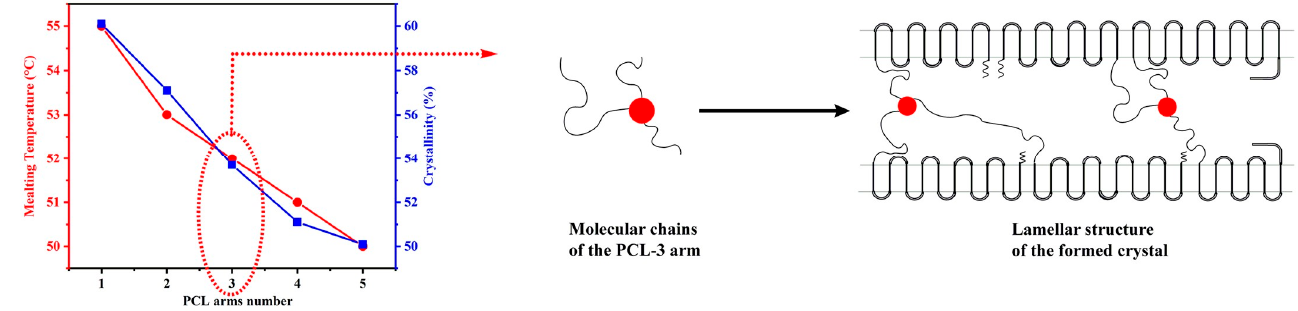
Figure 3. Influence of Arm Number in PCL Star Polymers on Melting Temperature, Crystallization Temperature, and Degree of Crystallinity. Table 2. The variation of thermal and crystallinity characteristics in accordance with the macro- molecular architectures of PCL-based multi-arms.